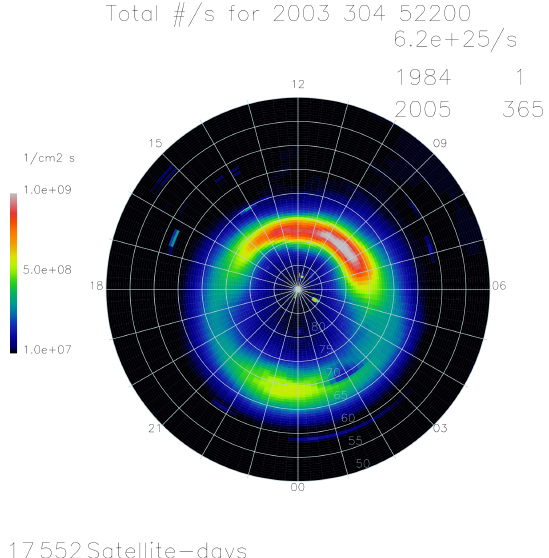
Figure 9. OVATION Prime 2013 particle flux for 31 October 2003 at